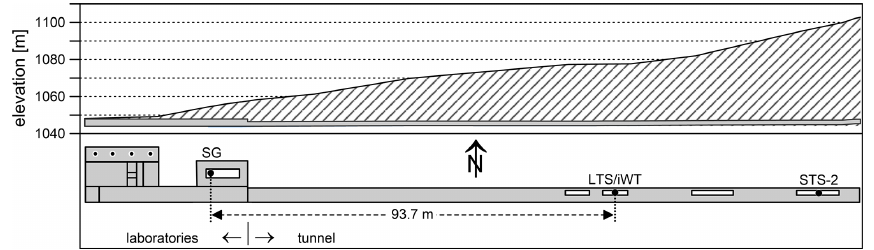
Figure 3. Vertical section and ground plan of the Conrad Observatory. Sensor positions are displayed by black dots. Small dots indicate boreholes of different